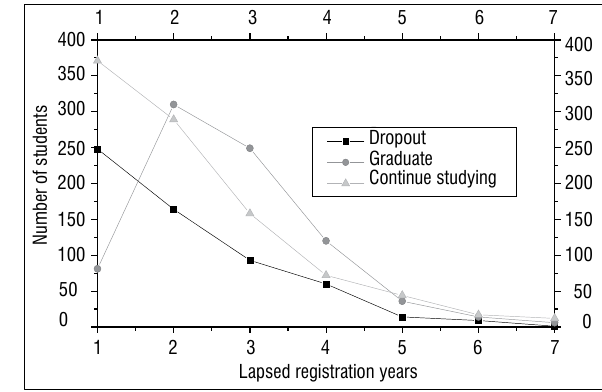
Admission pattern of full-time master’s students enrolled at University of KwaZulu-Natal. Age of master’s students on admission to the University of KwaZulu-Natal according to faculty descriptive statistics Faculty